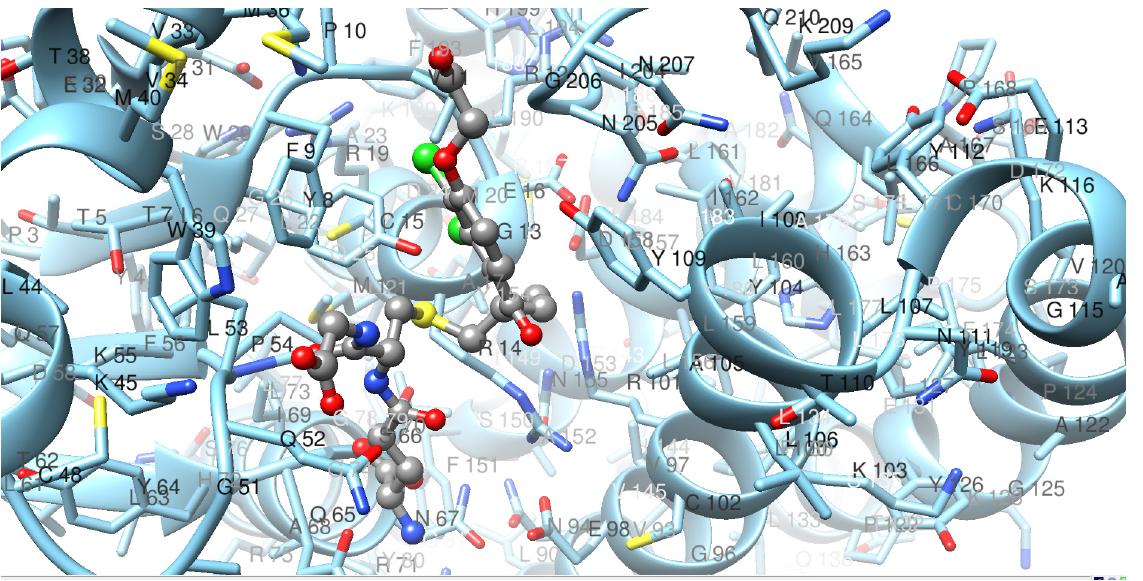
Figure 3. Structure of dog GST P1-1 with the conjugate of the substrate ethacrynic acid and glutathione (in color by element) bound to the active site. The model constructed in Modeller is based on the corresponding human crystal structure PDB ID: 11GS.